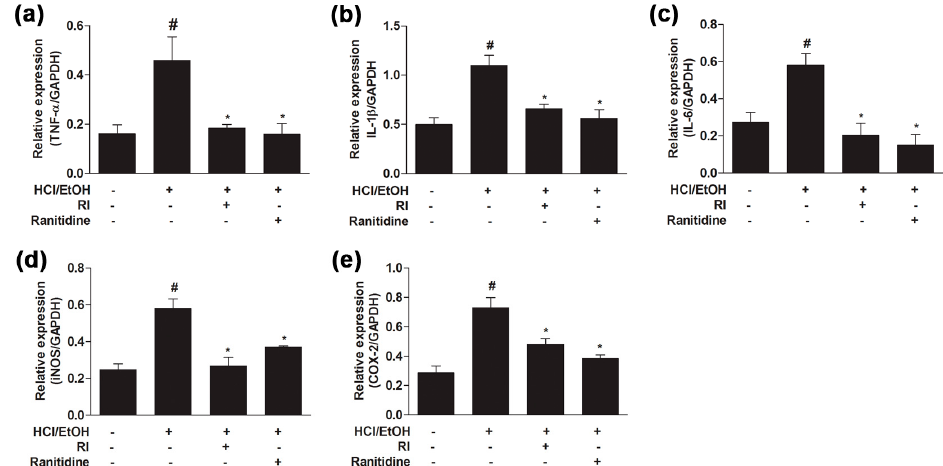
Figure 4. Protective role of RI on gene expression of pro-inflammatory cytokines in gastric tissue. In HCl/EtOH-treated mice, gene expression level of: ( a ) TNF- α ; ( b ) IL-1 β ; ( c ) IL-6 ; ( d ) iNOS ; and ( e ) COX-2 were significantly upregulated, whereas pretreatment with the RI markedly downregulated the gene expression level as related to ranitidine. # p < 0.05 when compared with control and * p < 0.05 when compared with HCl/EtOH. Data are expressed as mean ± SEM.